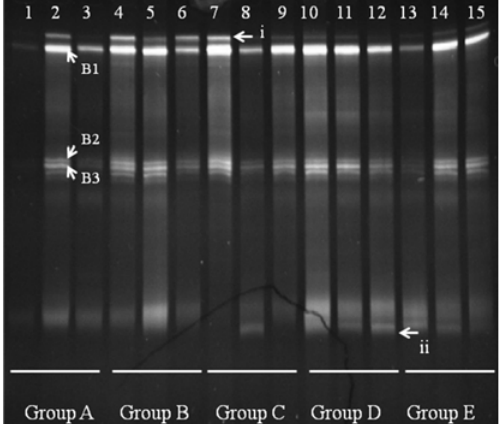
Figure 4. Denaturing gradient gel electrophoresis (DGGE) for Lactobacillus obtained from mouse distal colonic microbiota. Lanes 1–3 (Group A) represent normal controls. Lanes 4–6 (Group B) represent infection models. Lanes 7–9 (Group C) represent infected mice treated with low-dose FTBE. Lanes 10–12 (Group D) represent infected mice treated with middle-dose FBTE, and lanes 13–15 (Group E) represent infected mice treated with high-dose FBTE. The arrows (i–v) indicate bands that changed in intensity.